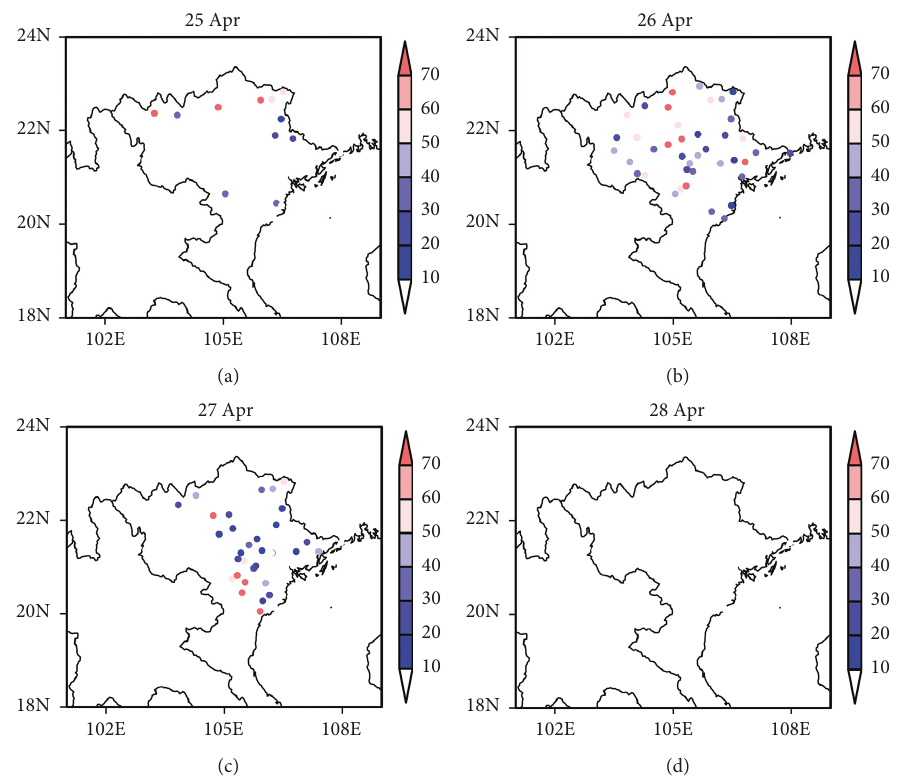
Figure 5: Daily rainfall at Northern Vietnam stations ( shaded , mm day 1) from 25 to 28 April